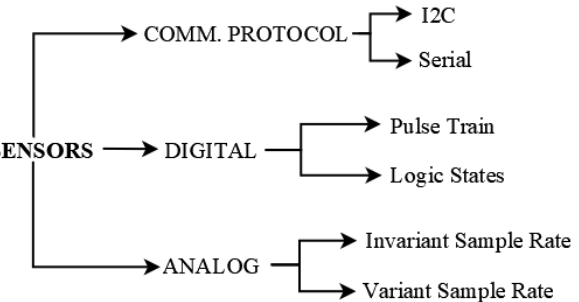
Figure 1. Proposed taxonomy of IoT sensors considering data processing